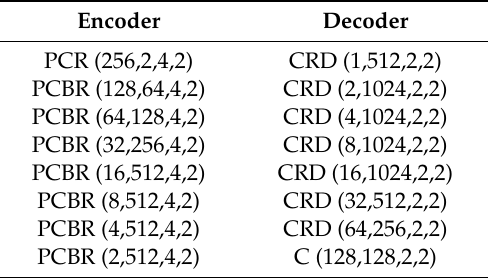
Table 1. Detail of the encoder and the decoder.